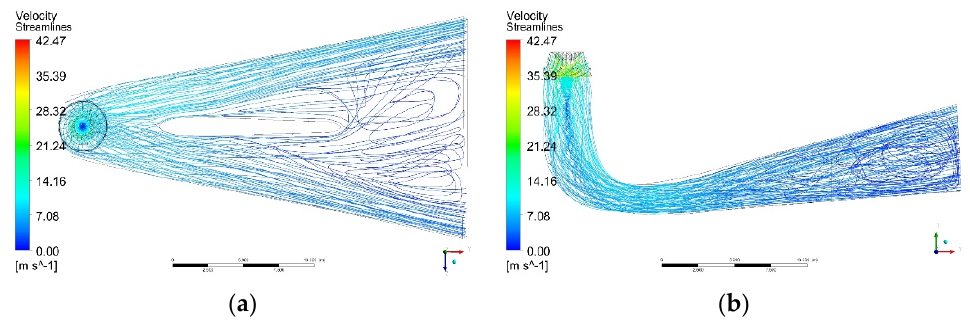
Figure 15. Velocity streamlines on the complete turbine, ( a ) upper view, ( b ) lateral View.